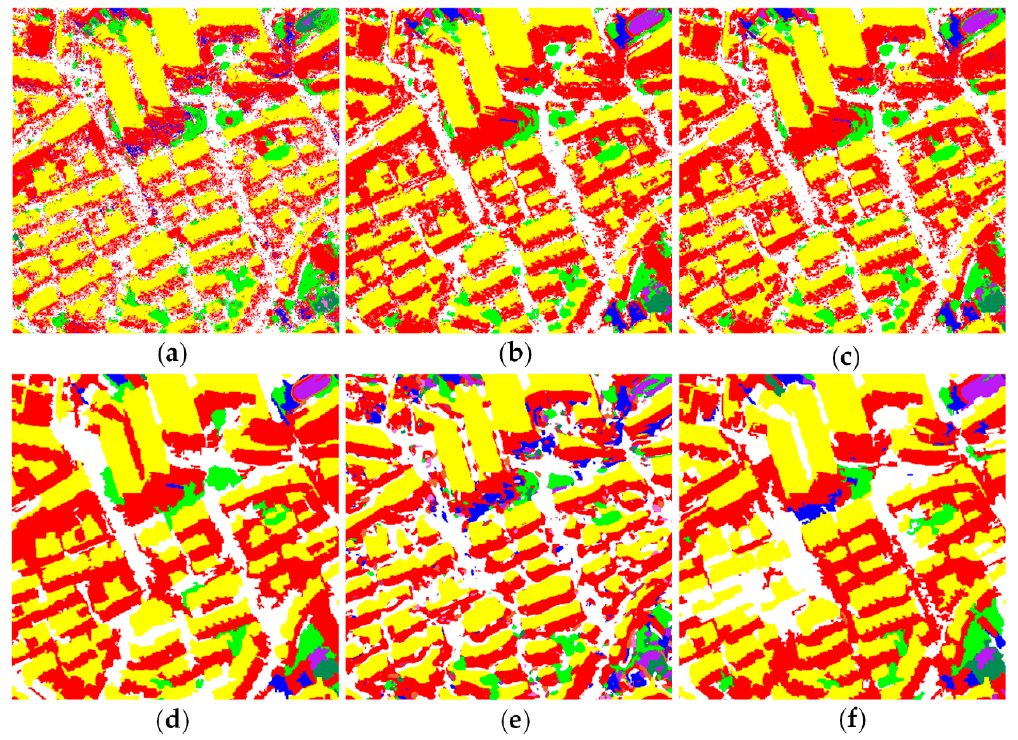
Figure 9. Local details of the classification results in residential area. ( a ) Raw; ( b ) SS; ( c ) OSS; ( d ) OSS-MSSC; ( e ) VGG; ( f ) VGG-MSS.